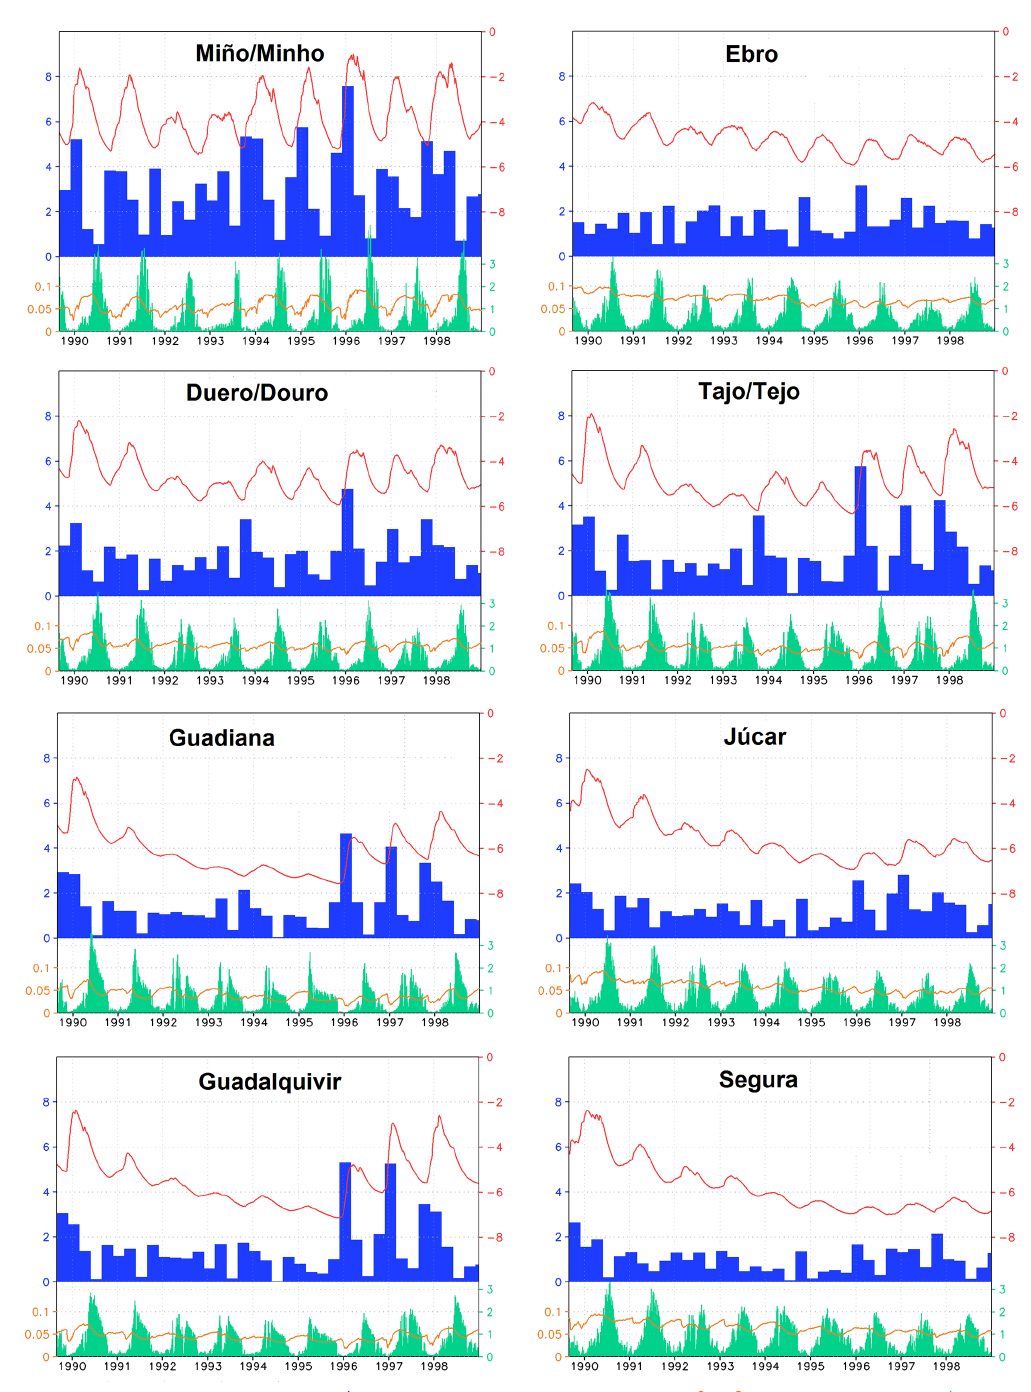
Figure 14. Results for the river basins in Fig. 13. Time series of seasonal precipitation averaged over the entire basin (mmd − 1 ; blue bars), averages over shallow water table cells only (wtd ≤ 8m) of wtd (m; red line), WT − FD top 2m soil moisture difference (m 3 m − 3 ; orange line) and WT − FD ET difference (mmd − 1 ; light green